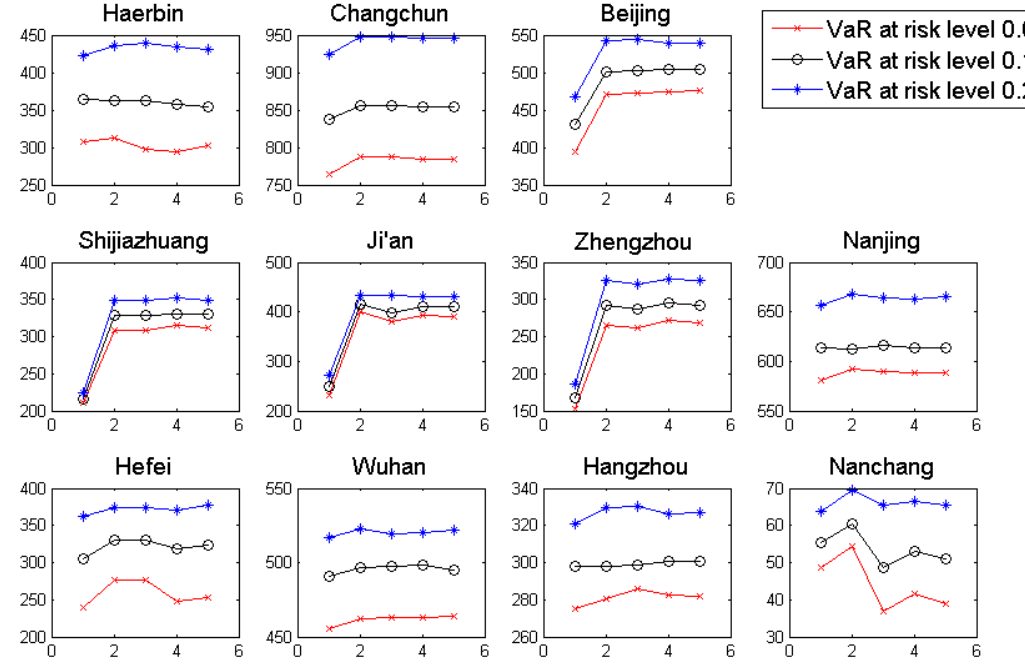
Figure 4. Comparison of VaRs that are without contract, with city-based contract (Case 1), with city-based contract (Case 5), with ACZB contract and with WCZB contract (left to right).